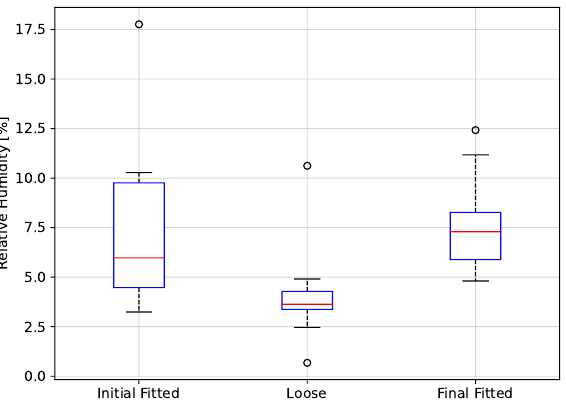
Figure 17. Peak to peak values of relative humidity as a function of fitting